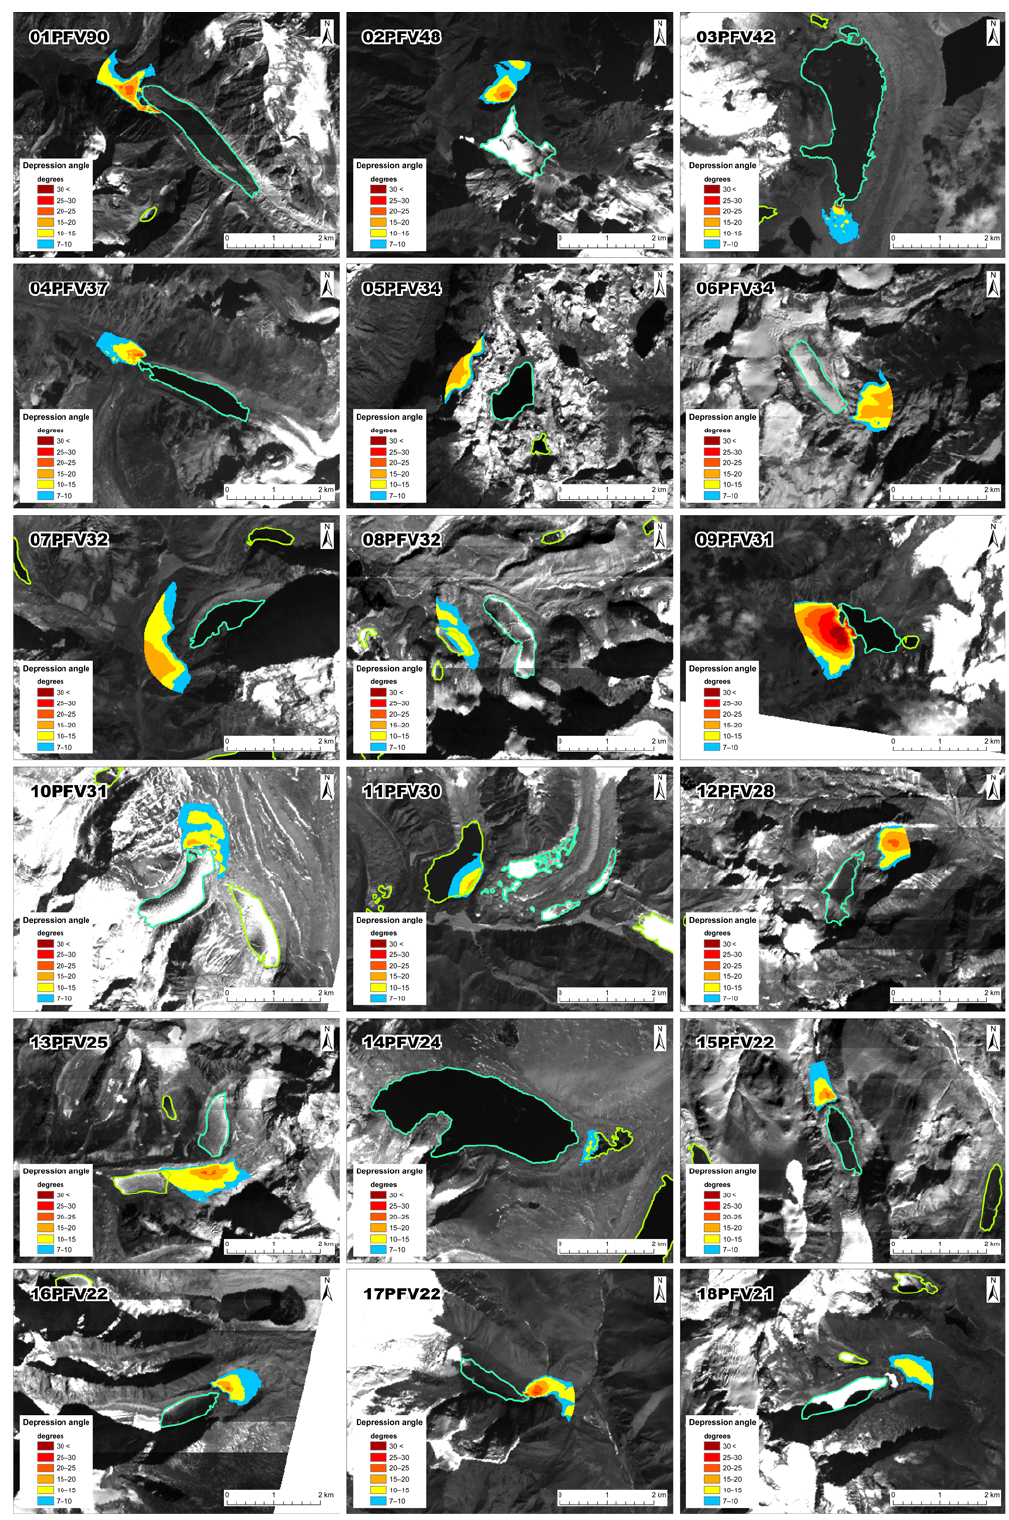
Fig. 8. Glacial lakes with a high PFV greater than 20millionm 3 . Light blue and light green polygons denote target and neighbouring other lakes, respectively. Steep lakefront area is shaded depending on steepness. The two digits before and after “PFV” denote its rank and volume (millionm 3 ) , respectively (details in Table